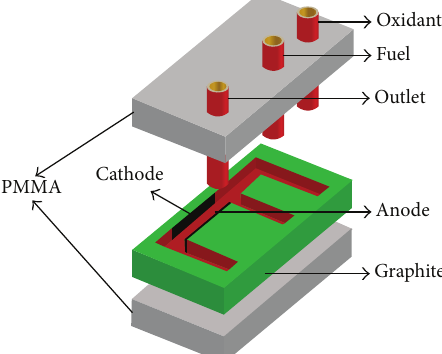
Figure 1: Schematic of the E-shaped membraneless laminar flow based fuel cell with graphite plates molded with PDMS poly(dimethylsiloxane) and sealed with PMMA poly(methylmetha-